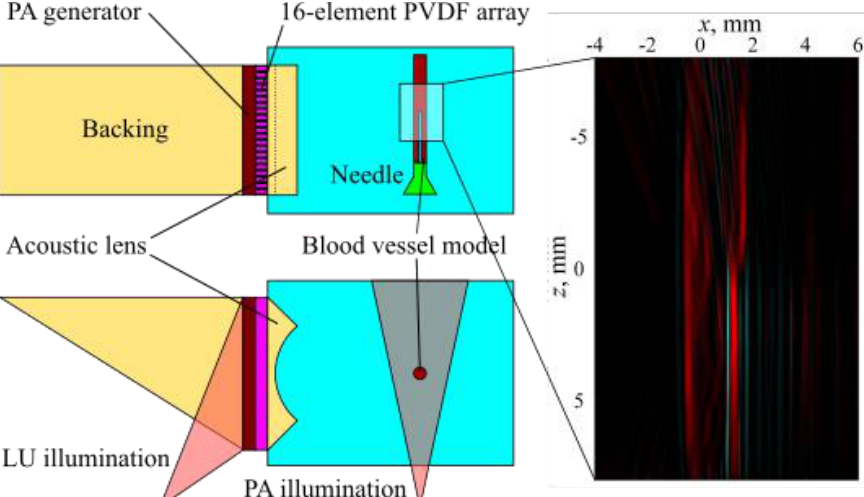
Figure 5. ( Left ) Schematic of the 2D combined imaging setup by Simonova et al. in the needle imaging scenario. ( Right ) Combined “PA + LU” image of a needle (0.7 mm in diameter) inside a blood vessel model (2.4 mm in diameter): red—PA image, cyan—LU image. Adapted with permission from [45], CC BY, 2017.